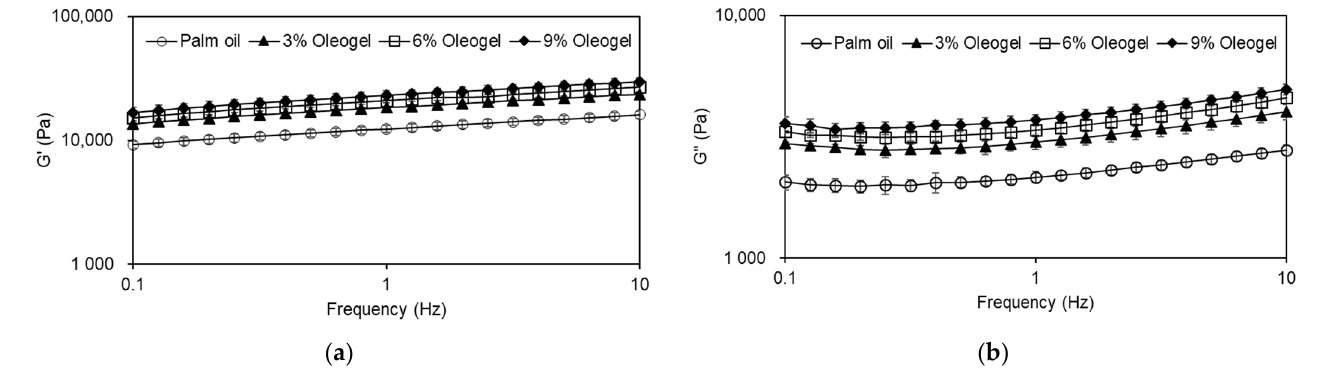
Figure 2. Effect of palm oil replacement with oleogels on the dynamic viscoelastic characteristics of imitation cheeses: ( a ) G’ (Storage module); ( b ) G’’ (loss module).